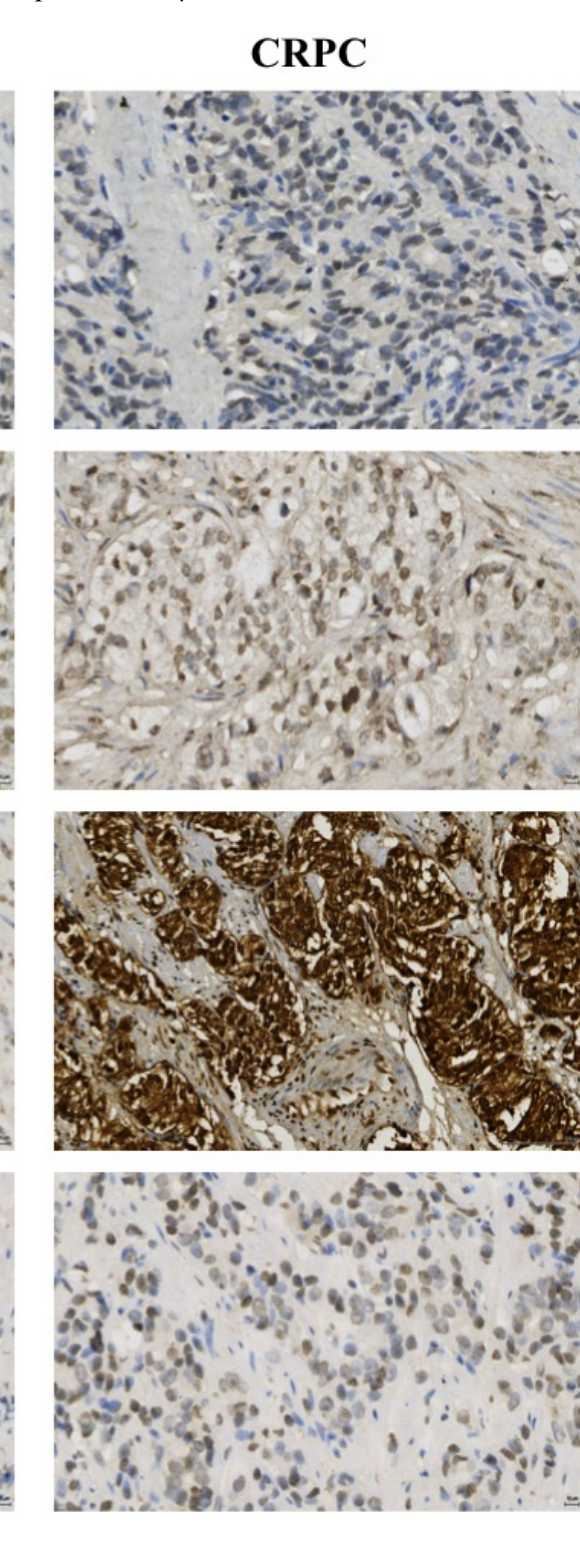
Figure 7. Prostate tumours displaying immunohistochemical staining of pAR 94 , pAR 308 , pAR 650 and pAR 791 . The bar on each image represents 10